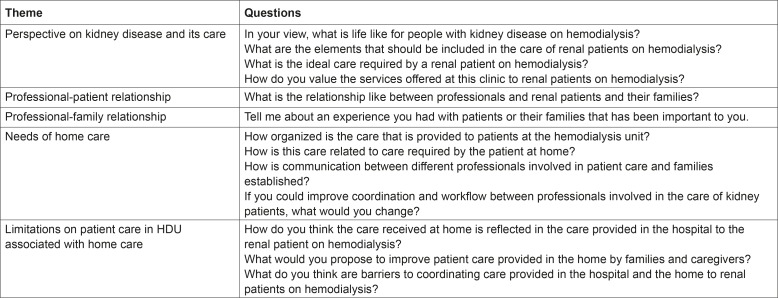
Interview Guide